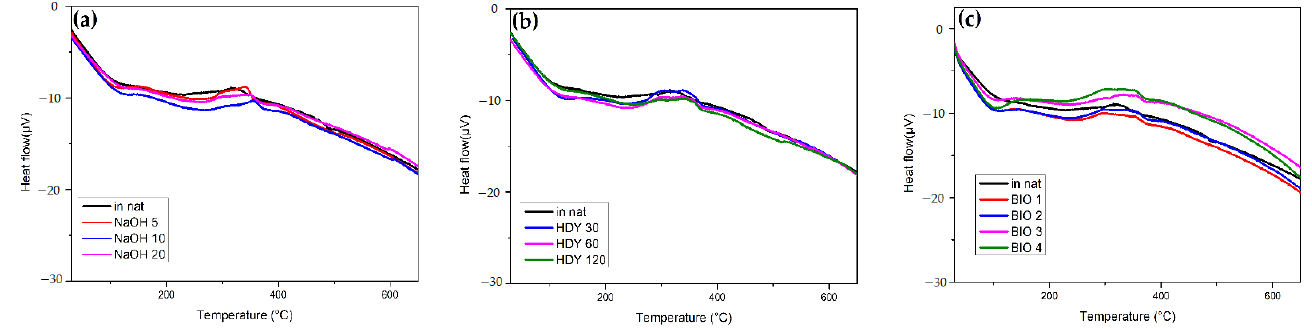
Figure 10. DSC for ( a ) NaOH; ( b ) HDY; and ( c ) BIO treatment.